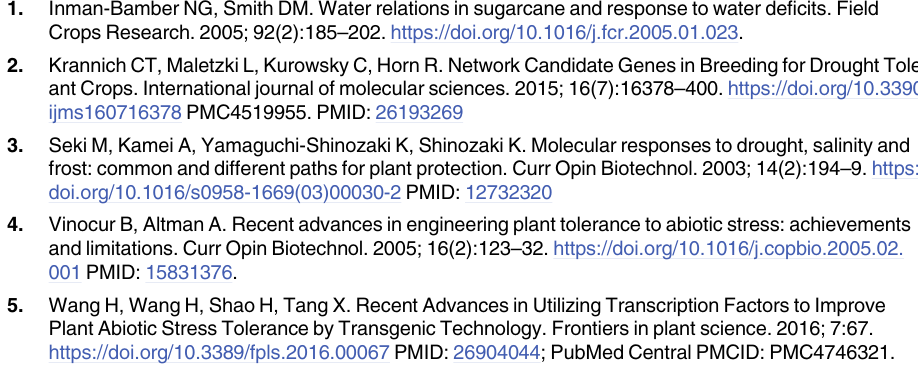
S1 Fig. Variation of soil moisture ( θ , m 3 m -3 ) measured every two days during well-water- ing and water withholding treatments. The values are mean ± SE (n = 4). (TIF) S1 Table. Percent identity matrix of a subgroup of MYB protein sequences. Protein sequences from monocots and A . thaliana : ScMYBAS1-2 (MH052202), ScMYBAS1-3 (MH052205), ScMY BAS1-4 (MH052203), ScMYBAS1-5 (MH052201), SbMYB23 (Sobic.005G224800.1),